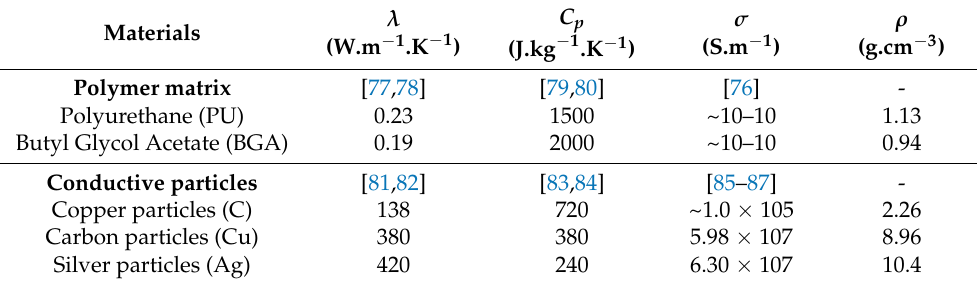
Table 5. General properties of matrices and particles used in the composite